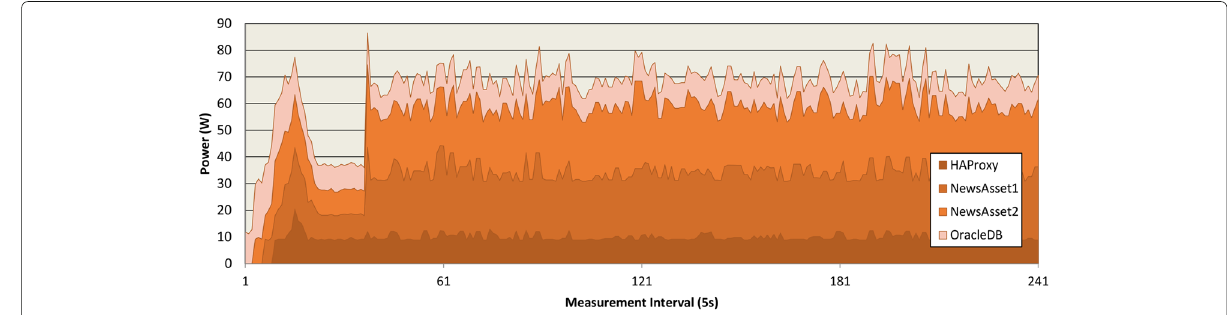
Fig. 13 News Asset Application Server Power